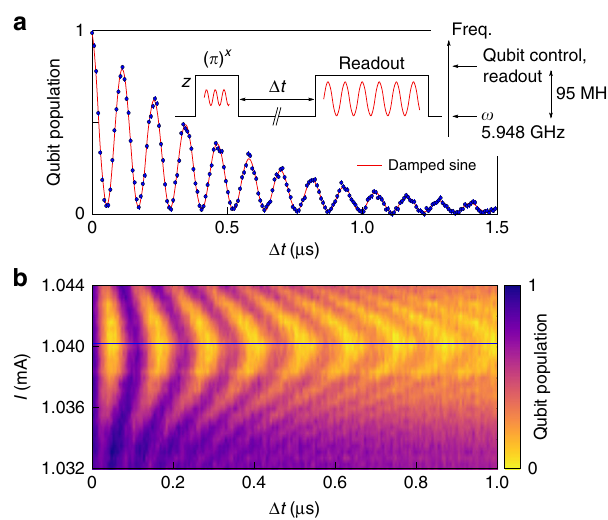
Fig. 2 Vacuum Rabi oscillations between qubit and bosonic mode. a The qubit is initially dc-biased on resonance with the bosonic mode, while it is detuned for state preparation and readout. The solid black line in the inset depicts the fast fl ux pulses applied to the fl ux bias line and indicates the qubit frequency on the given axis. Qubit and bosonic mode are on resonance during an interaction time Δ t . A frequency fi t ( red ) of the vacuum Rabi oscillations yields 2 g /2 π = 8.5 MHz. With the decay rate Γ = (2.08 ± 0.03) × 10 6 s − 1 of the envelope and the qubit decay rate 1/ T 1 = (0.2 ± 0.12) × 10 6 s − 1 we extract the bosonic mode decay rate κ = (3.9 ± 0.13) × 10 6 s − 1 . Error bars denote a statistical s.d. as detailed in the Methods. b For departing from the resonance condition ( blue line ) by varying the dc bias current I , we observe the expected decrease in excitation swap ef fi ciency and an increase in the vacuum Rabi frequency. The qubit population is given in colors and we applied a